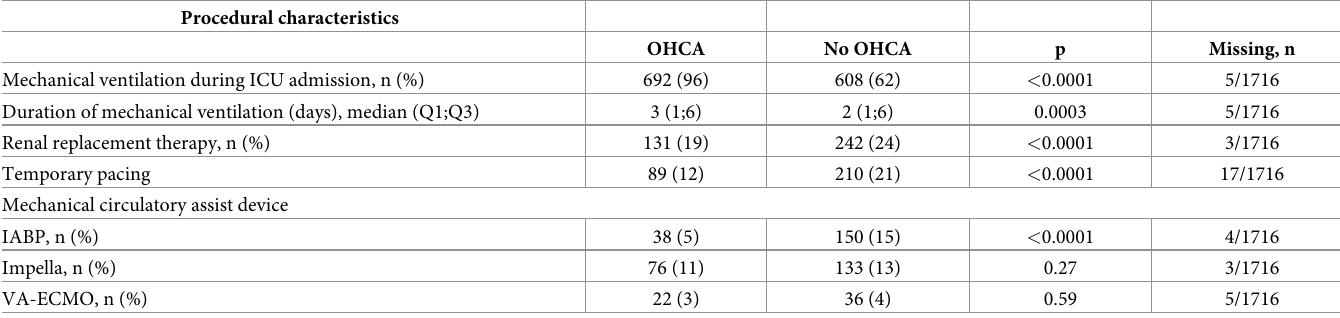
Table 2. Procedural